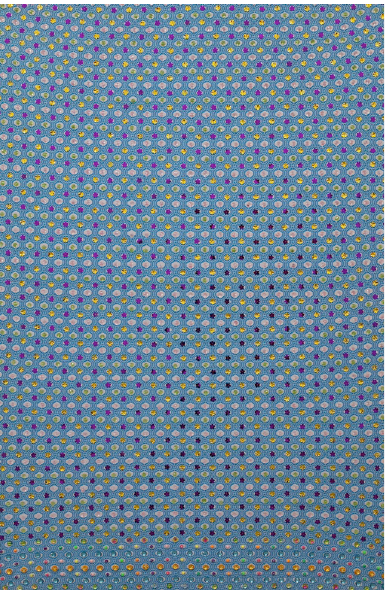
Figure 7 Chan Dany, Sampot: The Collection of Small Things (The Light of Color), 2013. Lycra, plastic lace, beads, cotton thread, 100cm x 150cm. Photograph by Lim Sokchanlina. Courtesy of the artist and SA SA